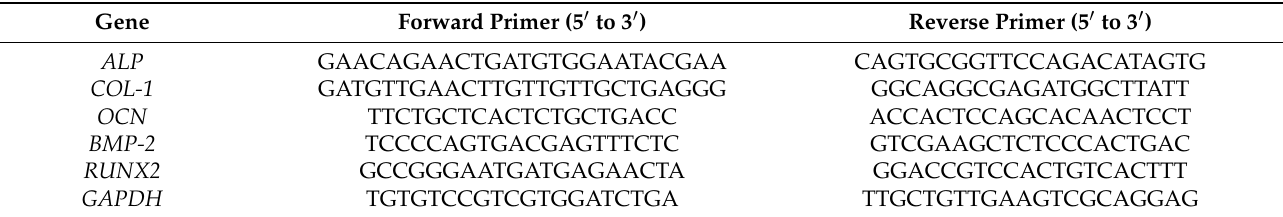
Table 1. Primer pairs used for gene expression analysis.